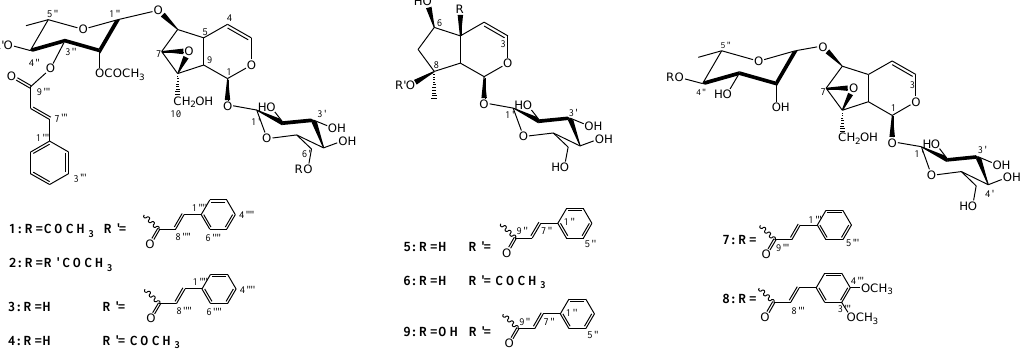
(devil’s claw) [34]. Harpagoside proved to have potent anti-rheumatic, anti-inflammatory and analgesic effects [35].